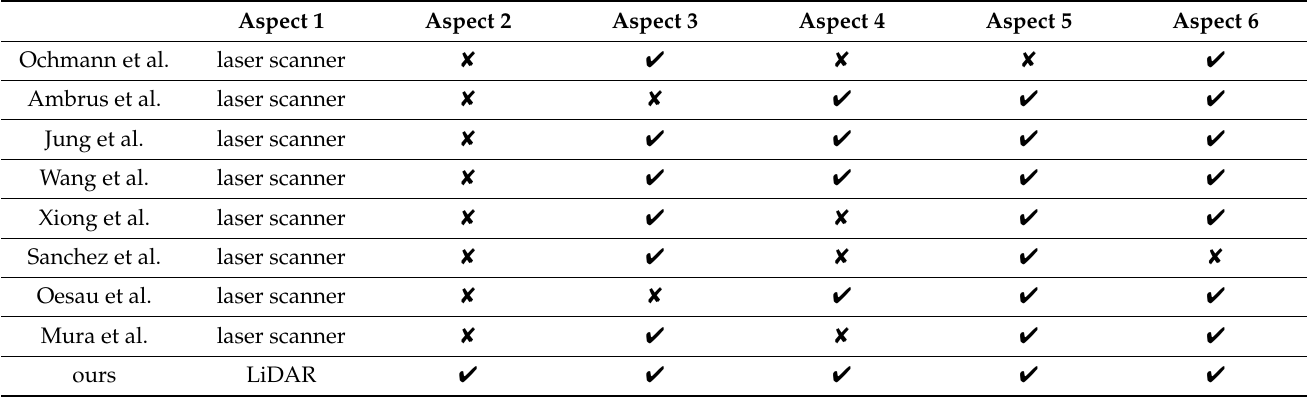
Table 10. Comparison of the characteristics of several different methods. Aspect 1: sources of data; Aspect 2: ground calculation; Aspect 3: filtering; Aspect 4: data optimization; Aspect 5: the manifestation of doors and windows; Aspect 6: accuracy of the number of